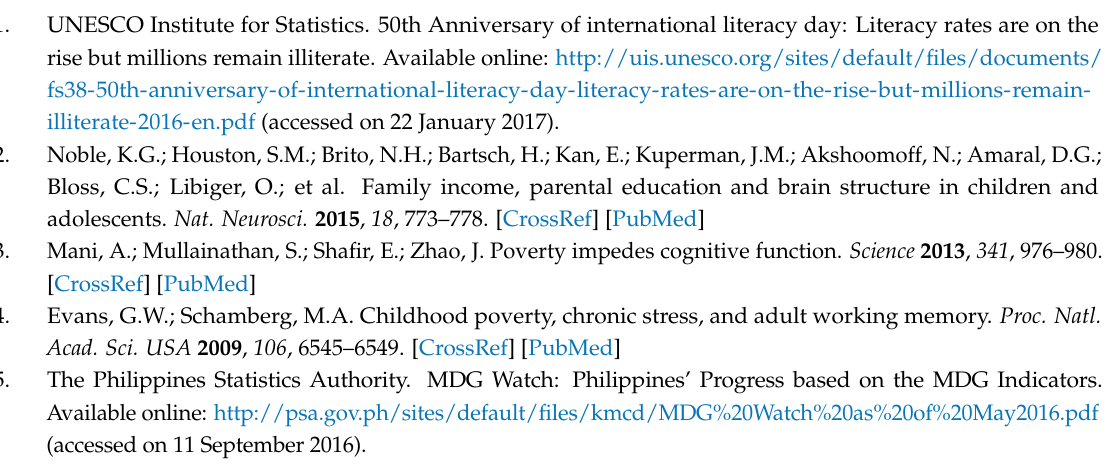
Text S1: Sampling methods of the Functional Literacy, Education, and Mass Media Survey (FLEMMS); Text S2: Results of semivariograms for prevalence of moderate functional literacy; Table S1: Household education stimuli score, Table S2: Results of semivariograms for prevalence of moderate functional literacy, Table S3: Results of semivariograms for prevalence of low functional literacy; Figure S1: Map of 2008 FLEMMS survey locations; Figure S2: Box plot showing the relationship between household education stimuli average total score and functional literacy indicators, by region; Figure S3: Bar graph showing basic household WASH characteristics; Figure S4: Maps of prevalence of moderate functional literacy of school-aged children in the Philippines by region; Figure S5: Maps of prevalence of low functional literacy of school-aged children in the Philippines by region; Figure S6: Semivariograms of prevalence of functional illiteracy in school-aged children; Figure S7: Semivariograms of prevalence of moderate functional literacy in school-aged children; Figure S8: Semivariograms of prevalence of low functional literacy in school-aged children.